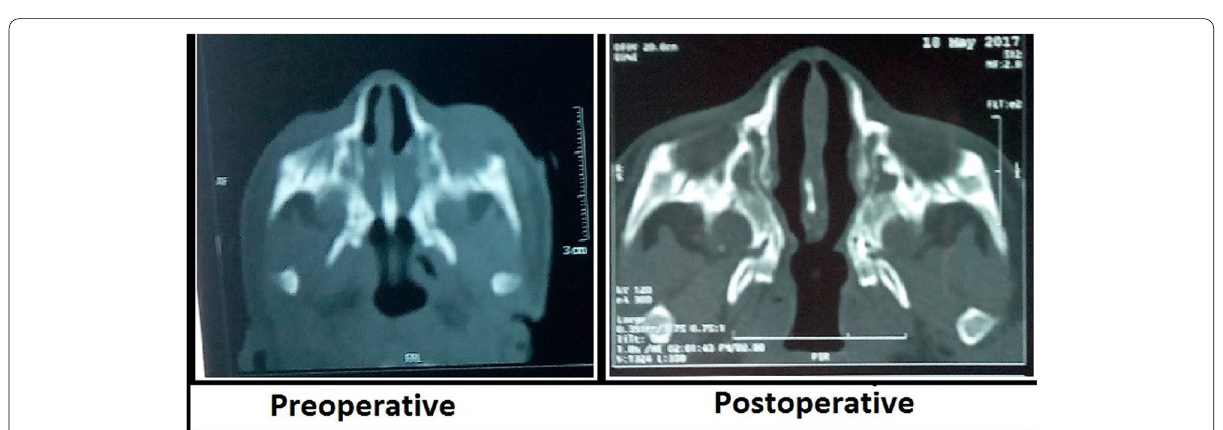
Fig. 2 Case number 1 in PPI group showing no choanal restenosis